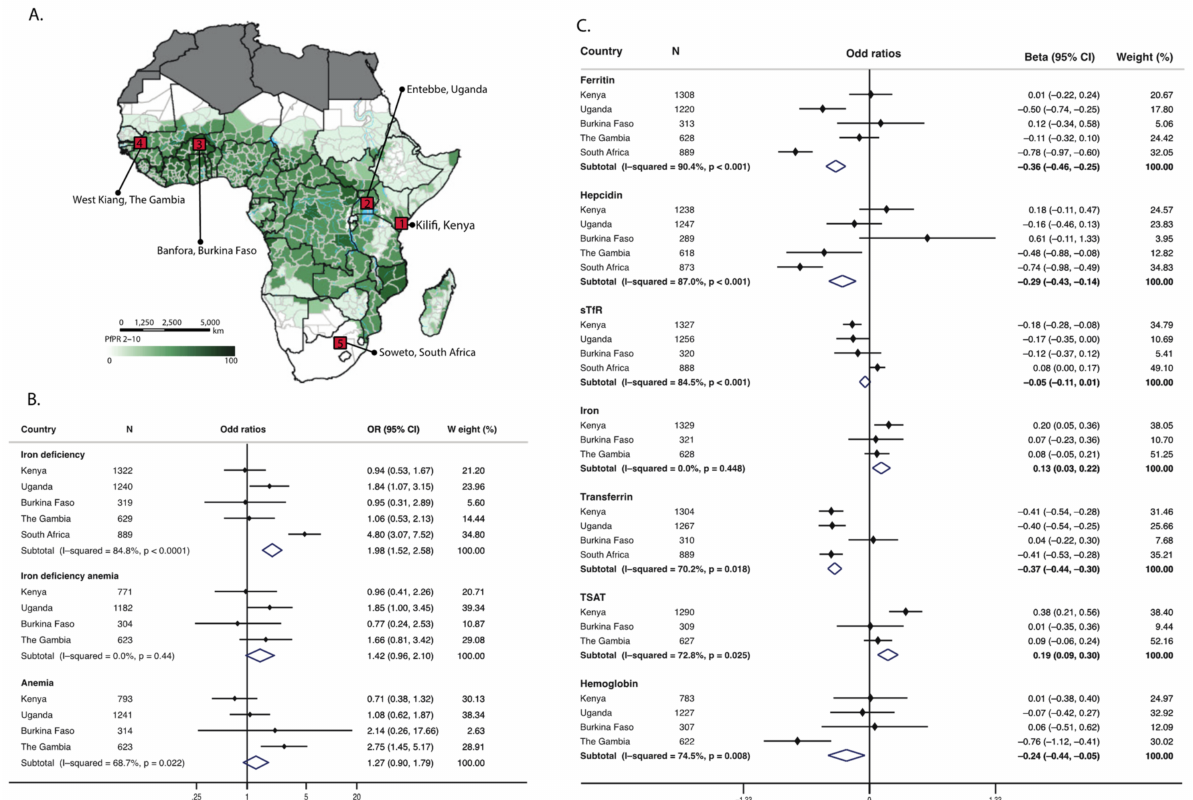
Figure 2. Map of Africa showing study sites ( A ), meta-analyses of associations between low vitamin D status (25(OH)D <50 nmol/L) and iron deficiency, iron deficiency anemia and anemia by study site ( B ) and meta-analyses of associations between low vitamin D status (25(OH)D <50 nmol/L) and individual markers of iron status ( C ). Abbreviations: sTfR, soluble transferrin receptors; TSAT, transferrin saturation. The map colors represent the predicted posterior predictions of age-standardized P. falciparum prevalence (PfPR2–10) as previously published by Snow et. al. [11]. Regression estimates were obtained from multivariable logistic regression analyses evaluating the effect of vitamin D status (25(OH)D <50 nmol/L against >75 nmol/L) on iron deficiency, iron deficiency anemia and anemia and on individual markers of iron status. Regression models were adjusted for age, sex, season, and inflammation. Meta-analysis of site-specific odd ratios was performed using metan package in STATA. Estimates for the meta-analyses for analyses using vitamin D status defined by 25(OH)D levels of 50–75 nmol/L are presented in Table S1. The map is adapted with permission from Snow et. al. (2008)